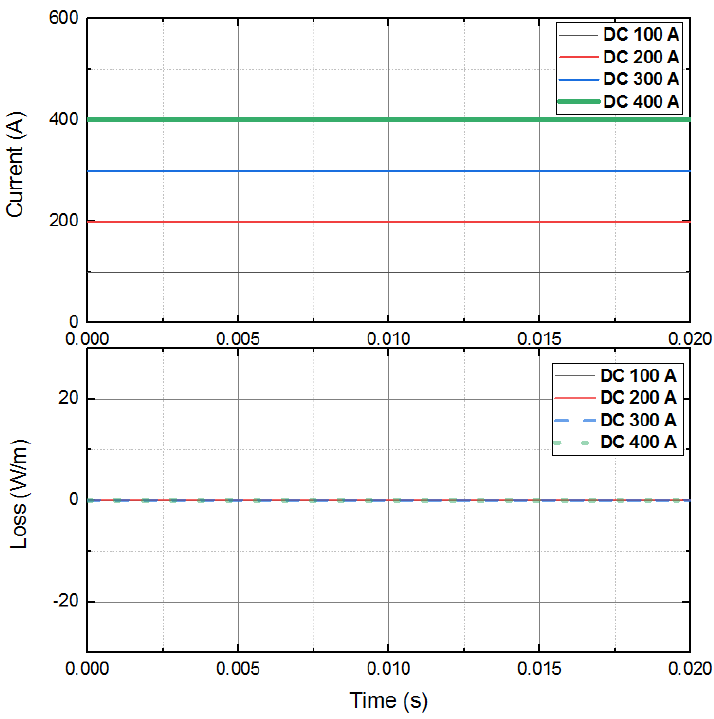
Figure 8. Losses in the HTS magnet with DC currents of 100, 200, 300, and 400